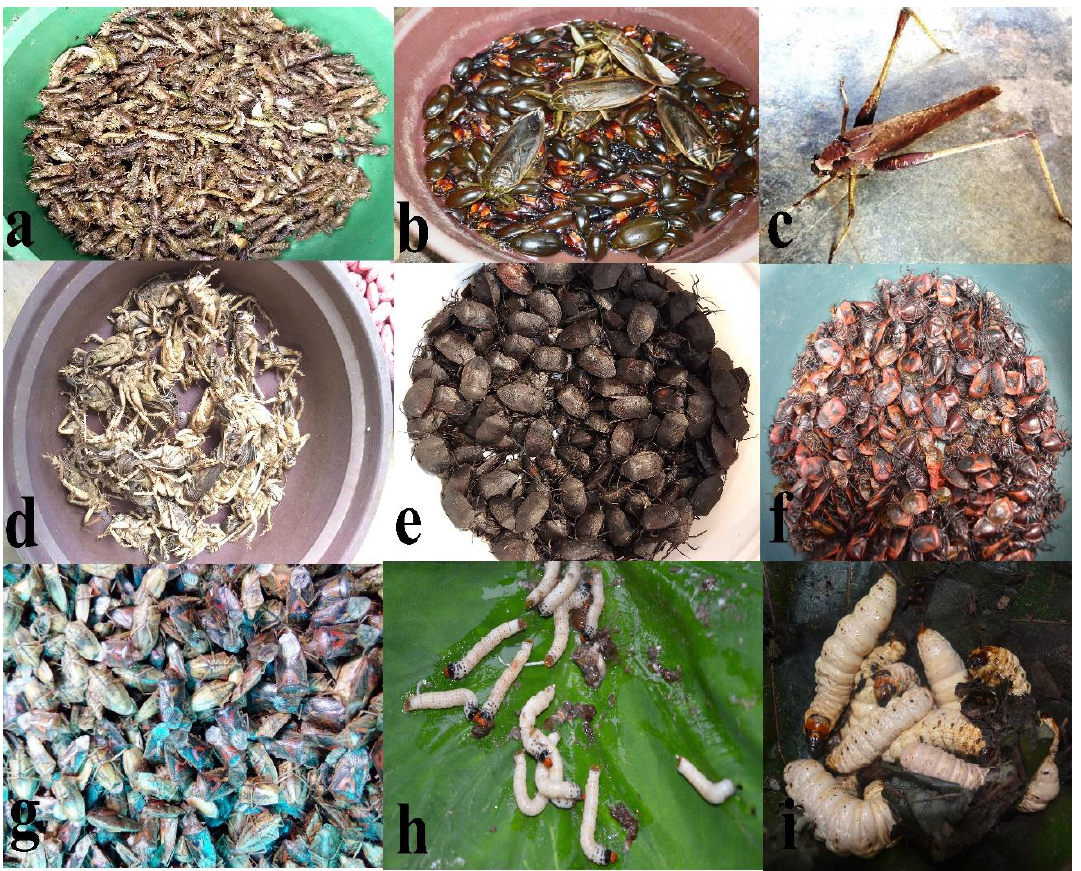
Figure 3. ( Plate 1 ). Certain popular edible insect species of Nagaland. ( a ) Dragon nymphs, ( b ) various aquatic insects, ( c ) katydid Mecopoda elongata , ( d ) the sand cricket ( Schizodactylus monstrosus ), ( e ) the dinorid bug Coridius singhalanus , ( f ) the red pumpkin bug Coridius janus , ( g ) sundried pentatomid bug Udonga montana , ( h ) the chrysomelid beetle Aplosonyx chalybaeus larvae, and, ( i ) large unidentified wood